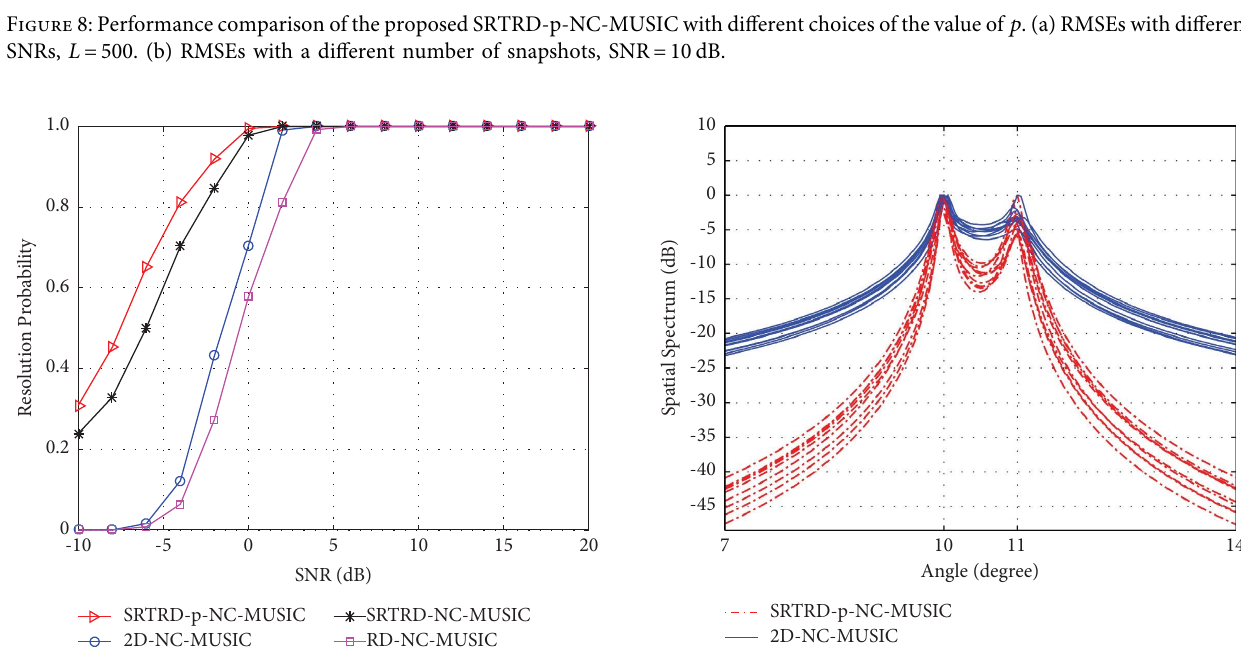
Figure 9: Resolution probability comparison with diferent SNRs, L � 500.